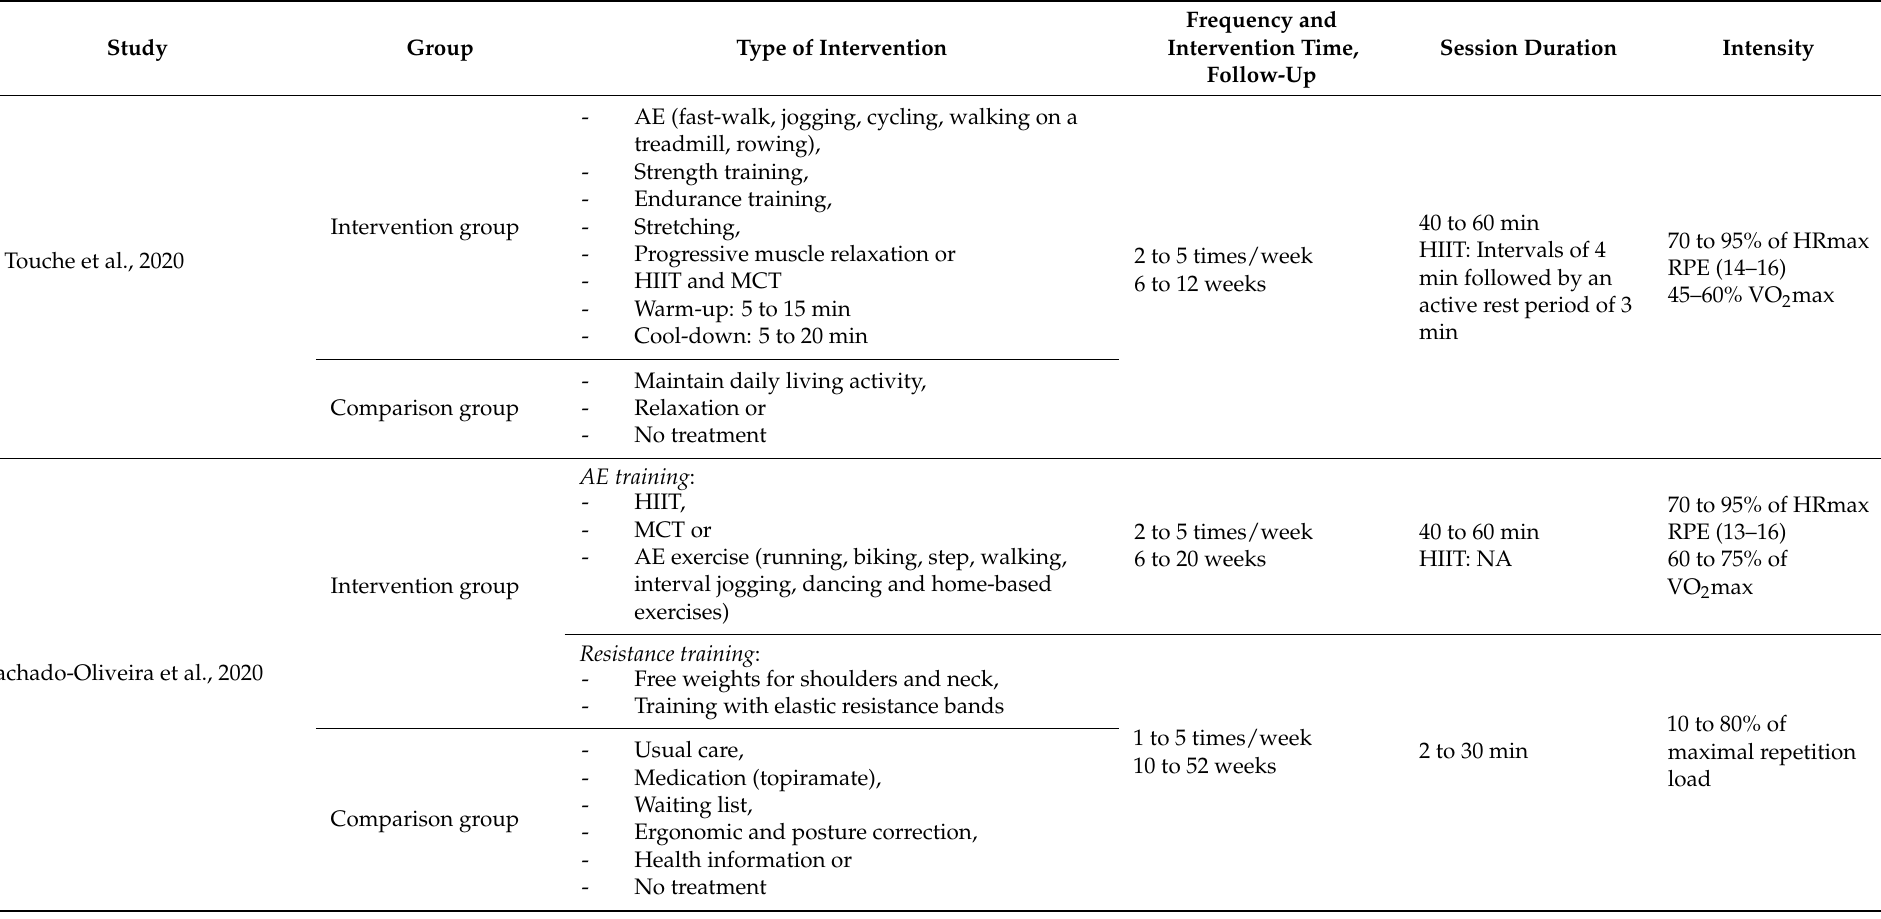
Table 2. Interventions included in each of the